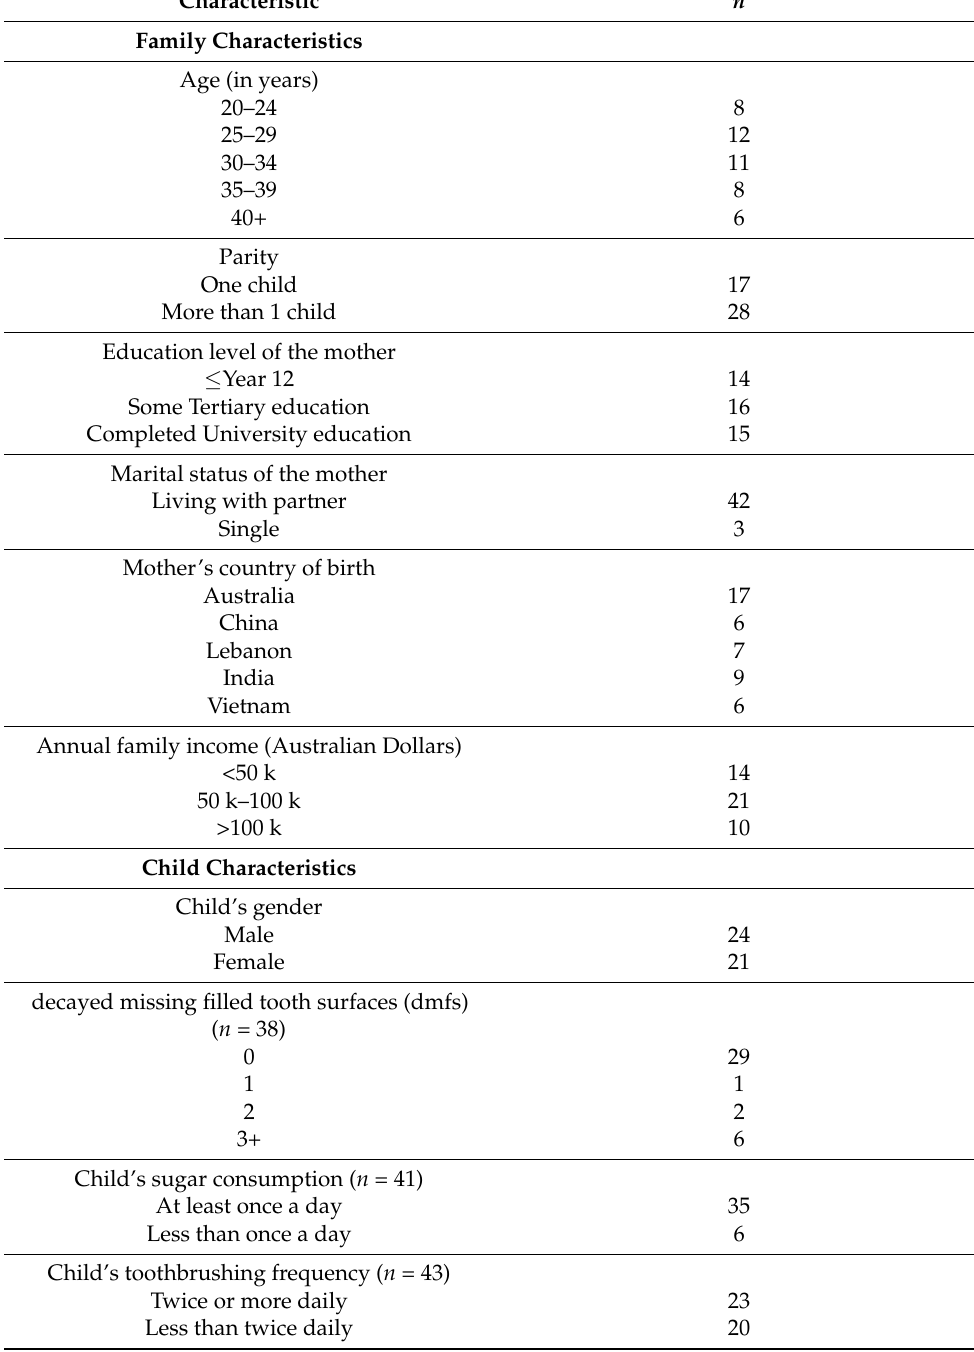
Table 2. Family and child characteristics of the study participants ( n =